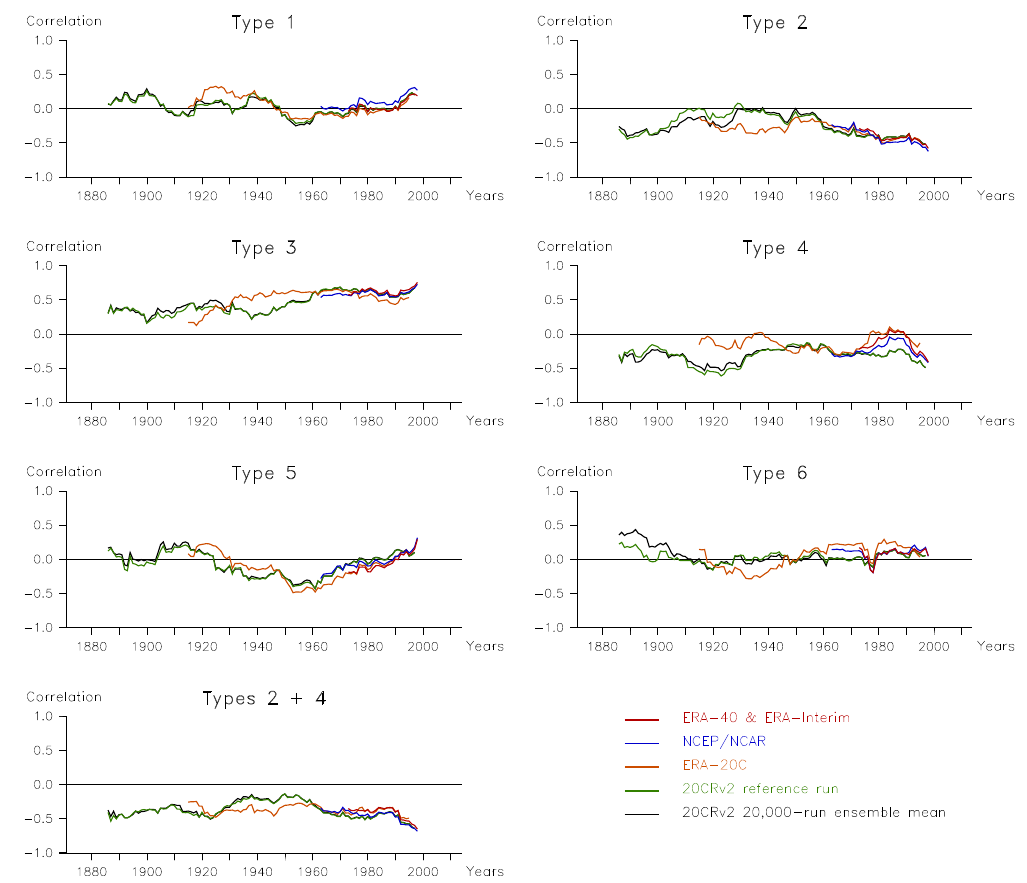
Figure 4. The 30-year running correlation is calculated between the annual (JJA) SLP-based frequencies of each type and the JJA CRU NAO index. For the “Types 2 + 4” correlation, the frequencies of types 2 and 4 have been summed before computing the